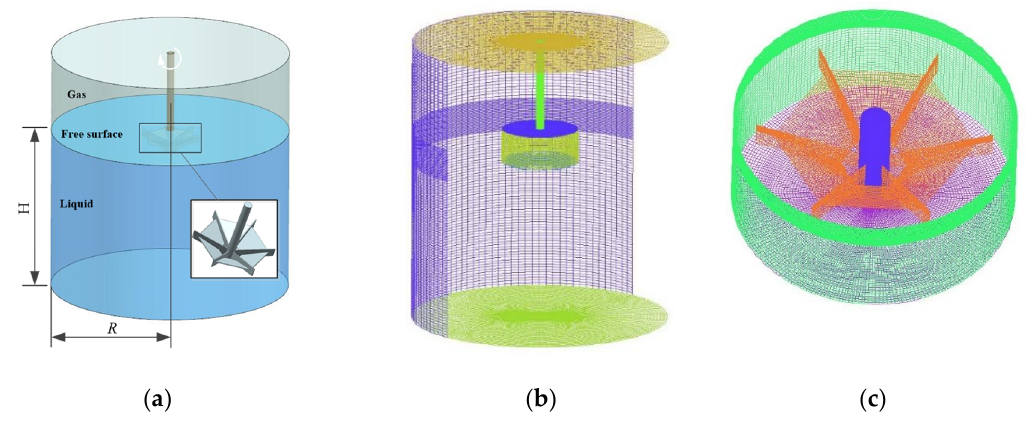
Figure 7. Computational domain and mesh. ( a ) Computational domain, ( b ) mesh generation, ( c ) mesh of the impeller. Table 4. The result of grid